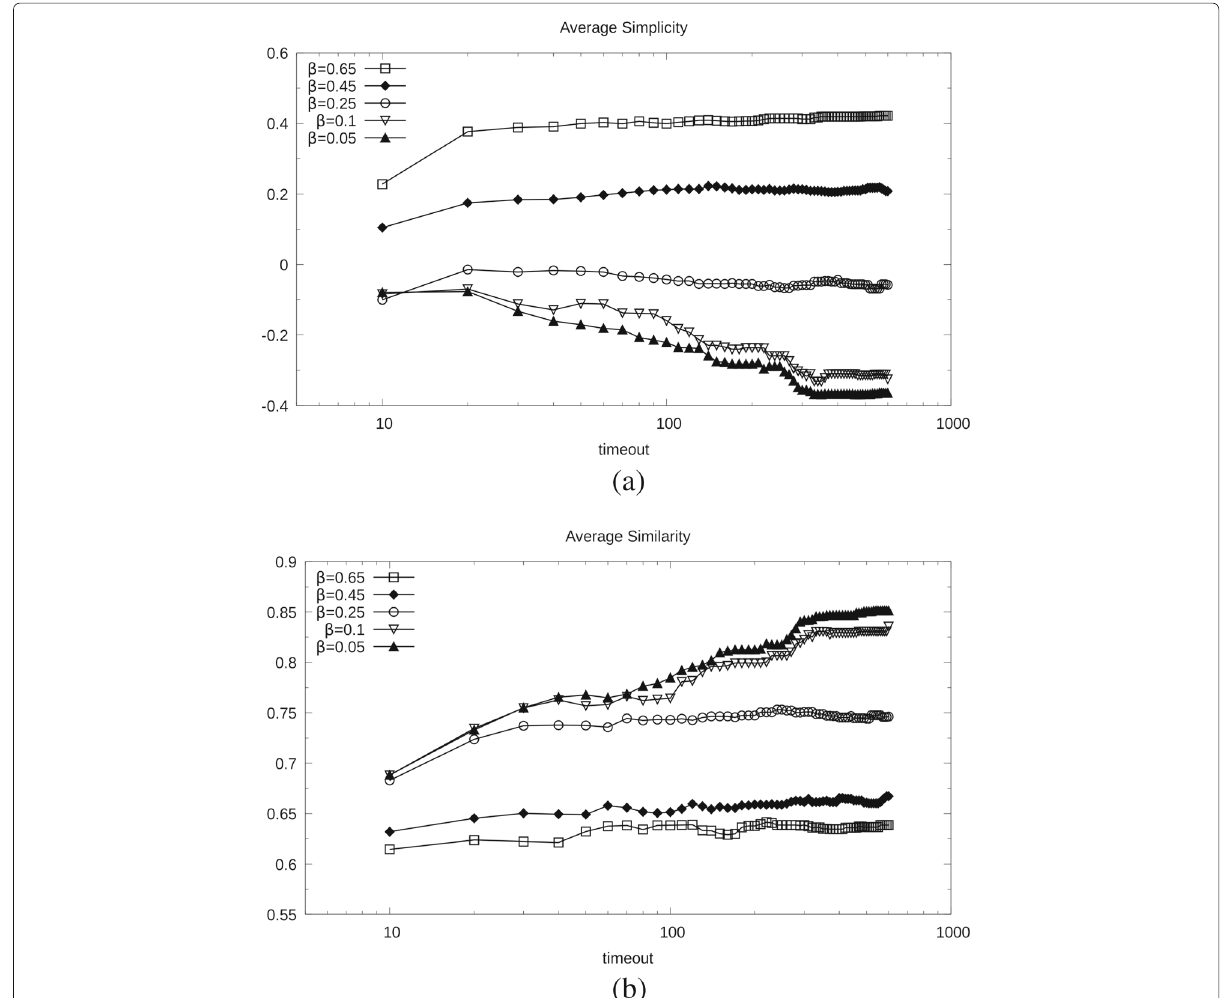
Fig. 6 Average simplicity ( a ) and similarity ( b ) in Domino (y axis) as a function of the timeout (x axis, secs) at difference balance points